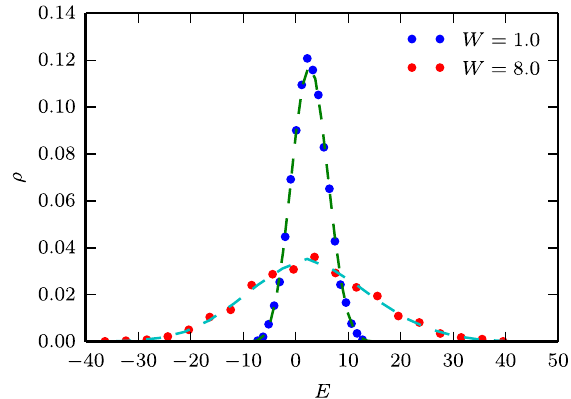
FIG. 2. Dashed lines: Density of states ρ ð E Þ obtained using full diagonalization. Points: ρ obtained using IQPE for k ¼ 16 bits. All results are for L ¼ 12